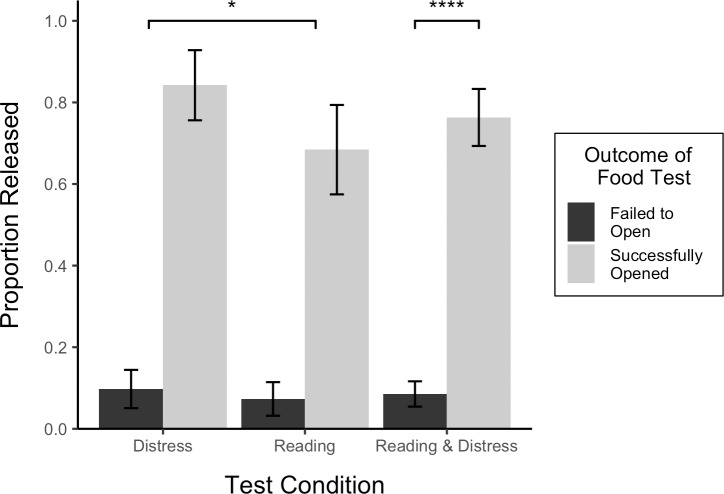
Proportion of owners released in the distress and reading tests by outcome of the food test.The distress test is shown in left cluster of bars, the reading test, in the middle cluster, and the distress and reading tests are combined in the right cluster. Error bars show standard errors.